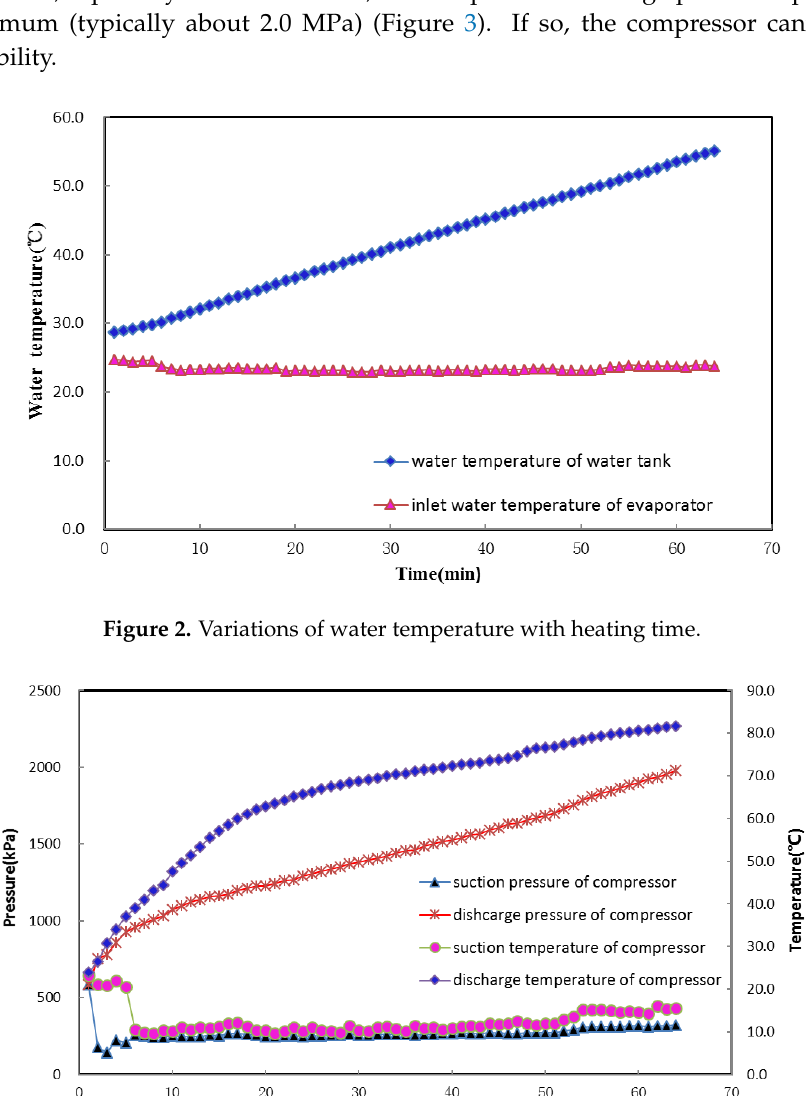
Figure 3. Variations of suction and discharge temperature and compressor pressure.